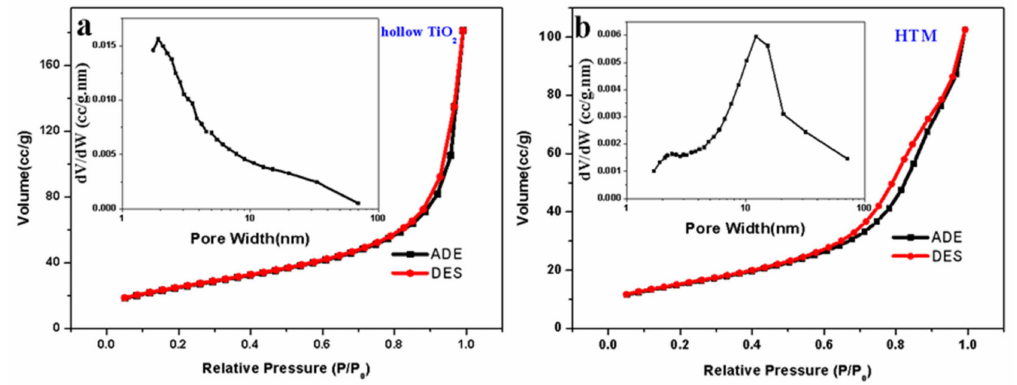
Figure 3. N 2 adsorption-desorption isotherms and pore size distribution (insert) of hollow TiO 2 ( a ) and HTM hollow spheres ( b ).